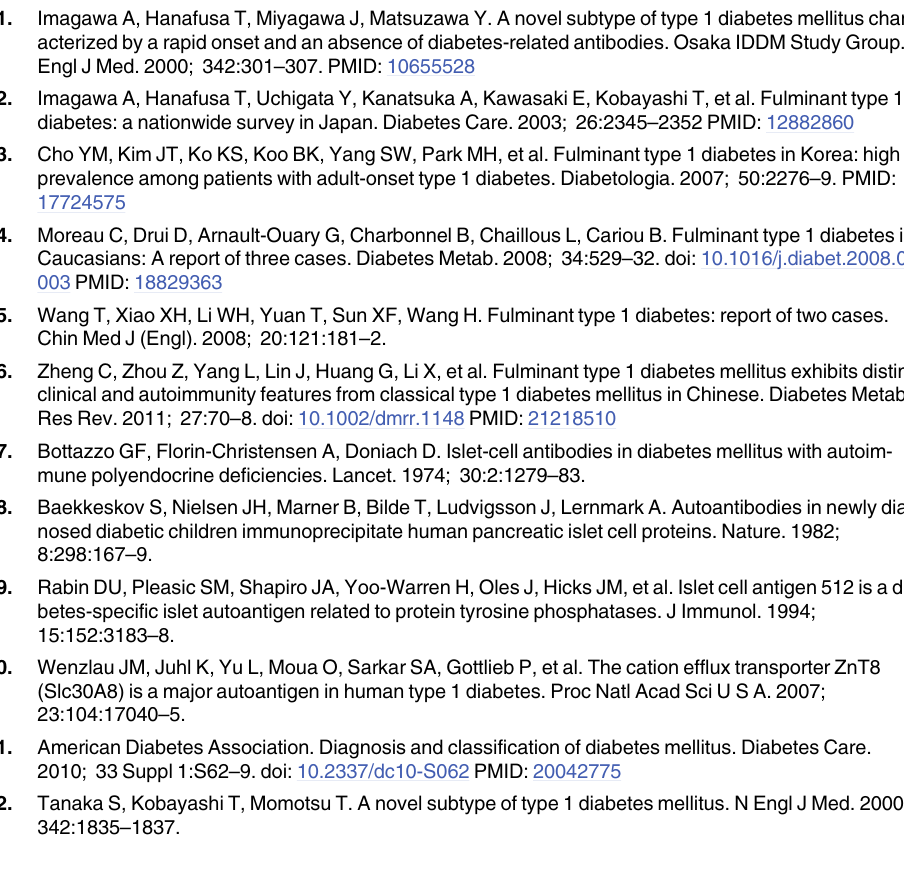
S1 Table. Antibodies for which the OD ratio of acute FT1D to sub-acute was > 1.4 in sero- mic